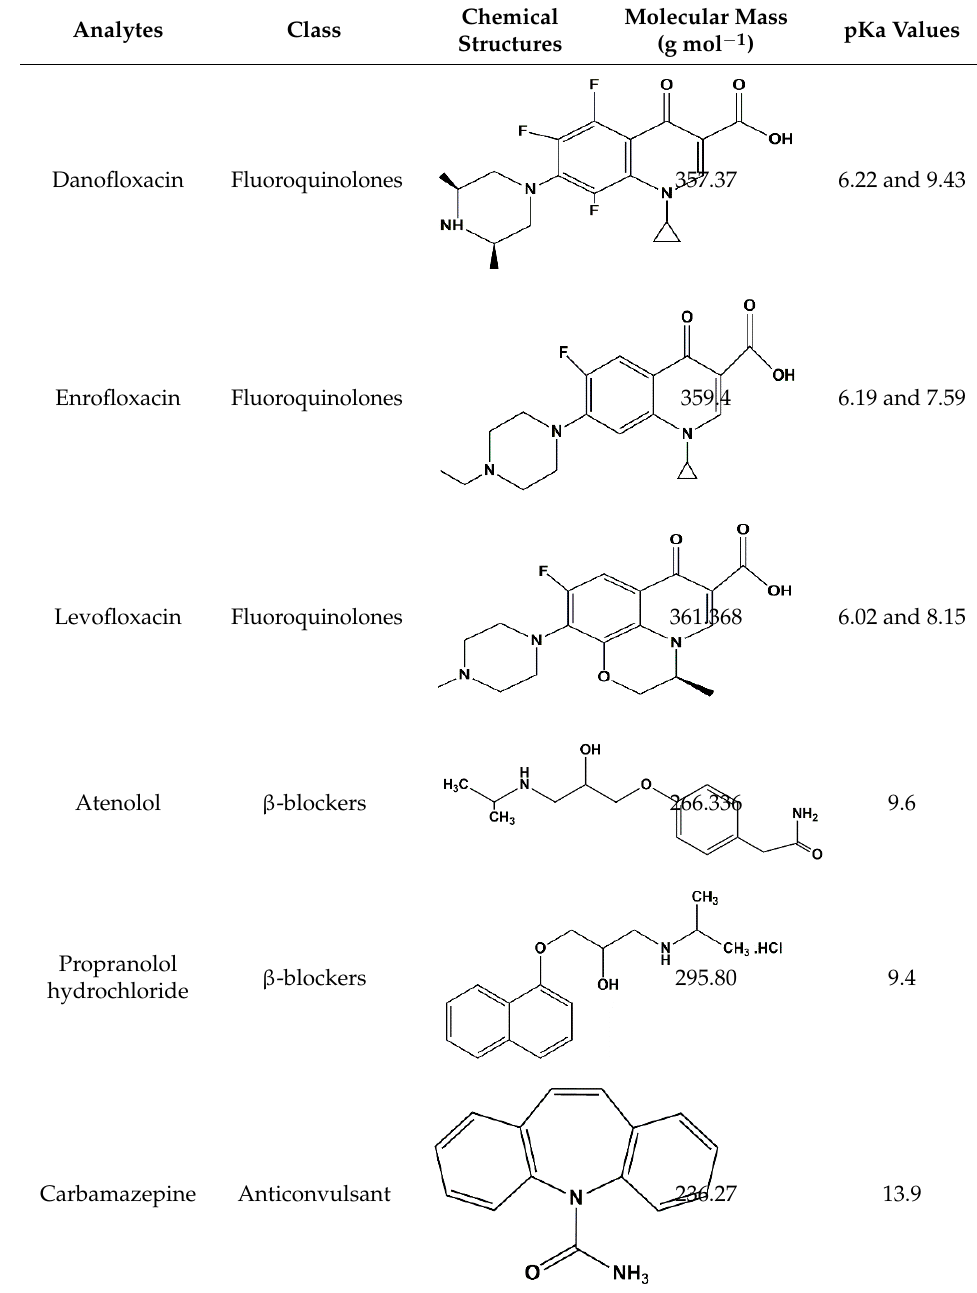
Table 1. List of pharmaceutical and personal care product (PPCP) compounds, chemical structures, molecular masses and pK a values.